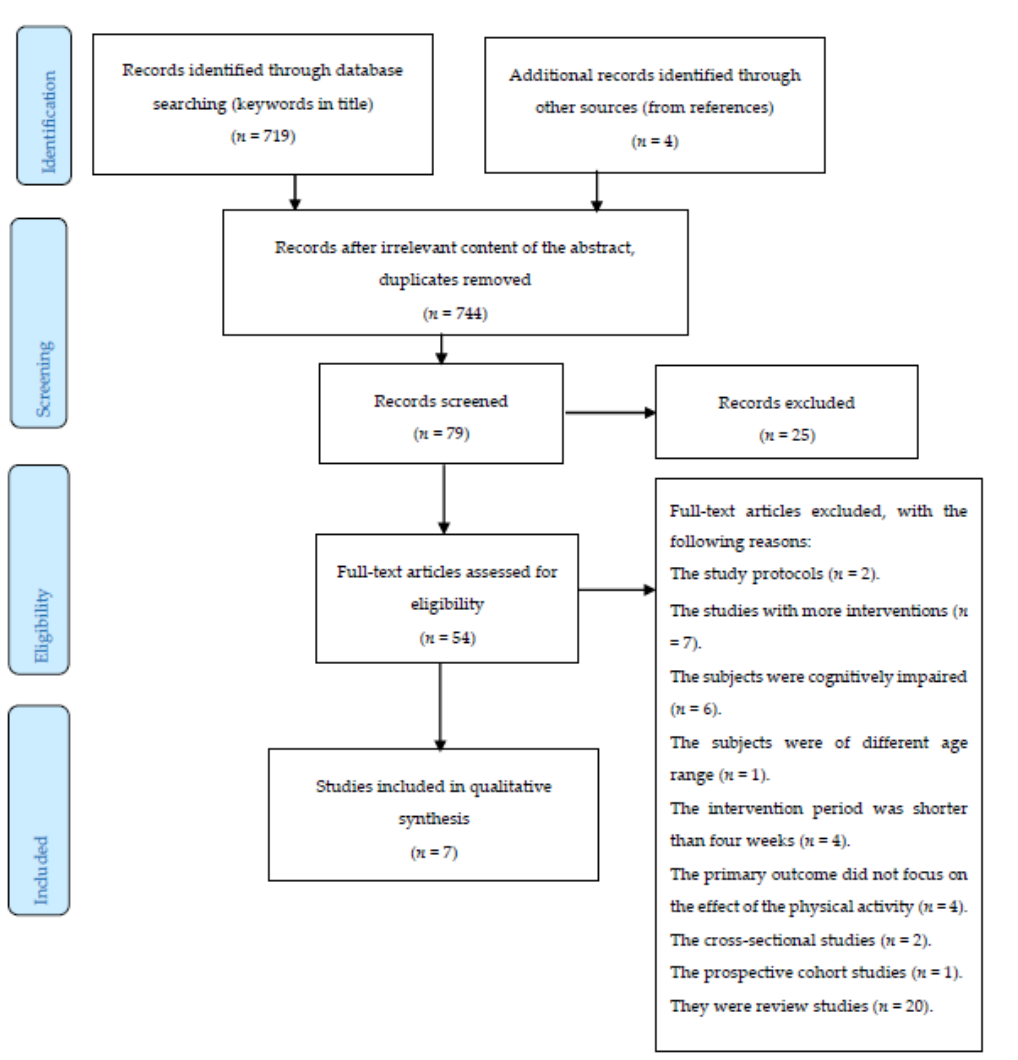
Figure 1. An overview of the selection procedure.